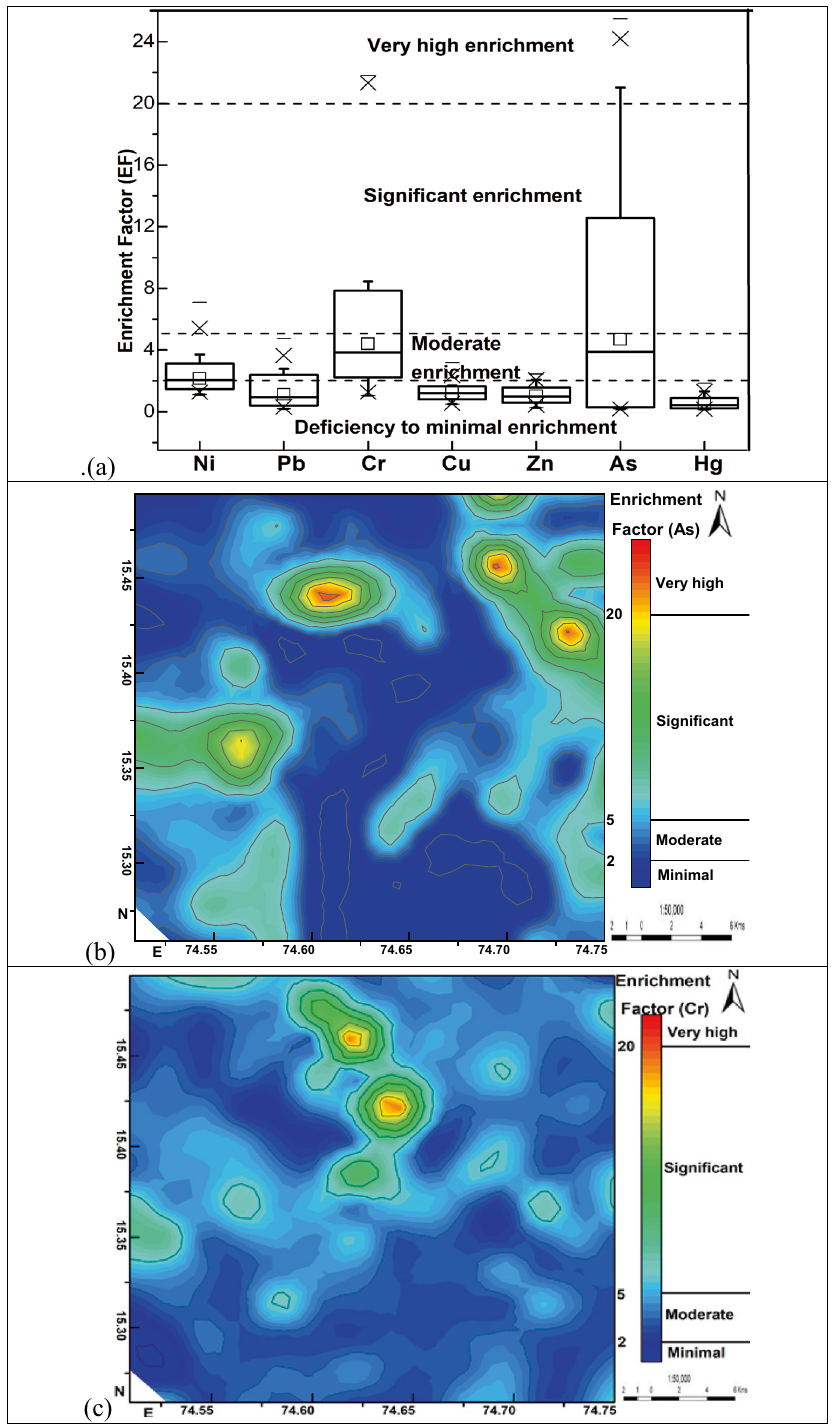
Figure 5. ( a ) Enrichment factor of selected heavy metals, the spatial distribution of enrichment factors for ( b ) As and ( c ) Cr in the surface sediment